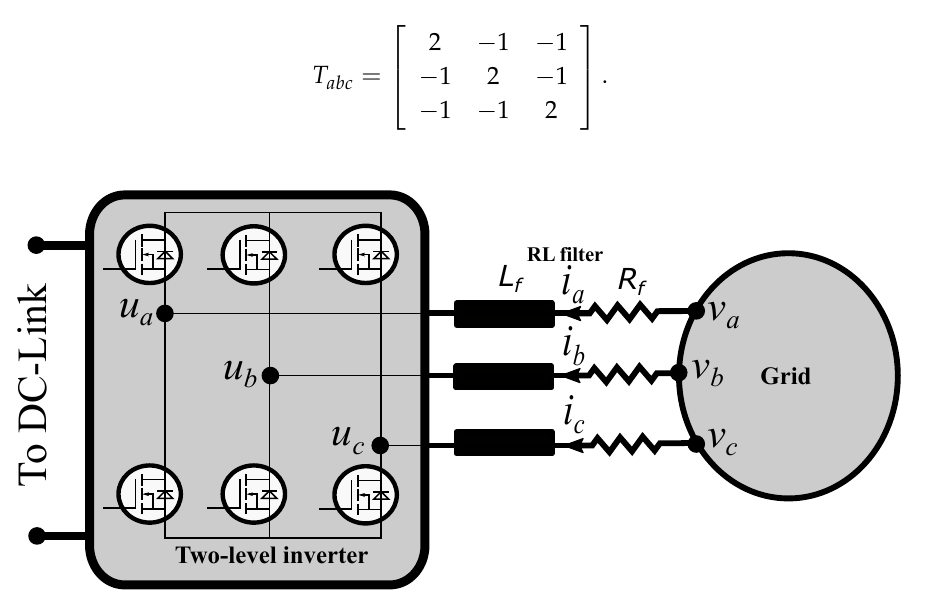
Figure 6. Configuration of the two-level inverter with grid